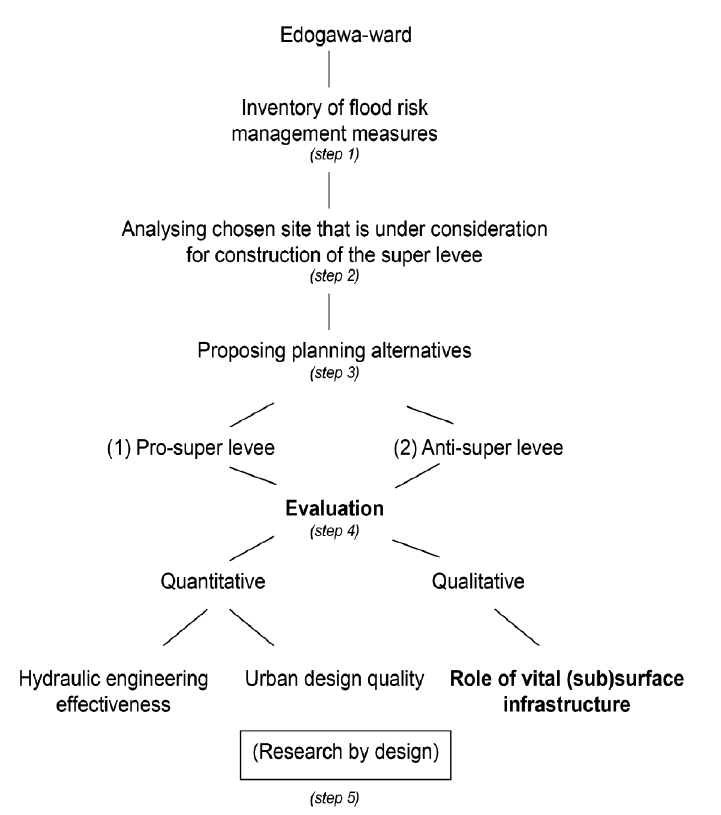
Figure 3. Research method and process